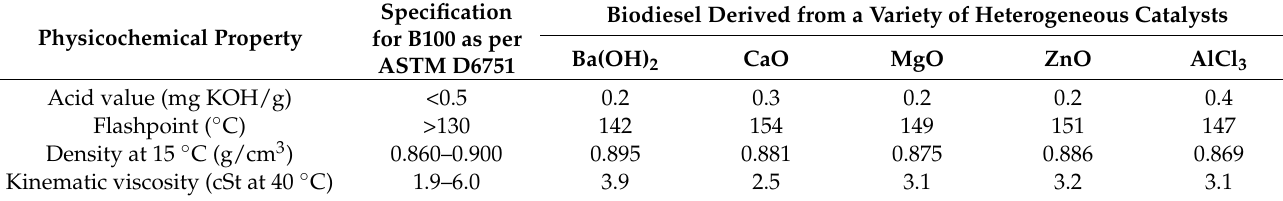
Table 2. Physiochemical properties of biodiesel.